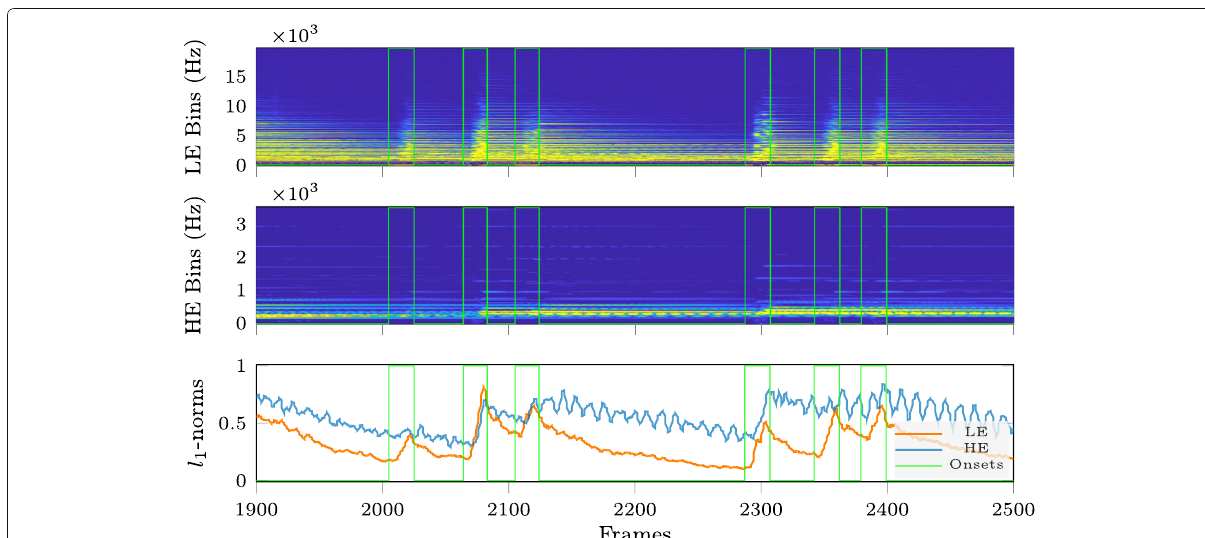
Fig. 2 Temporal variation of signal energy per frequency bin and of spectral sparsity for electric guitar (major seventh stopped) excerpt. Note onsets are indicated by vertical lines. (Top and middle) Low- and high-energy log-magnitude spectrograms. (Bottom) Low- and high-energy STFT log-magnitude coefficient vector (cid:4) 1 -norm variation